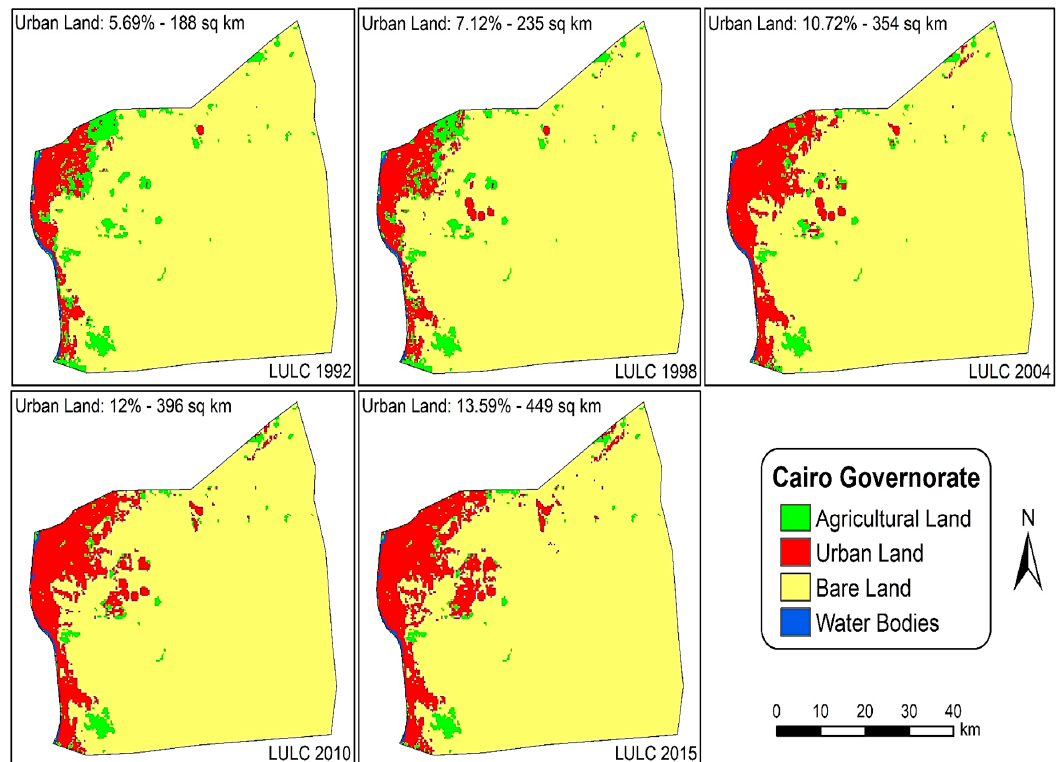
Figure A4. Urban expansion over Cairo governorate.